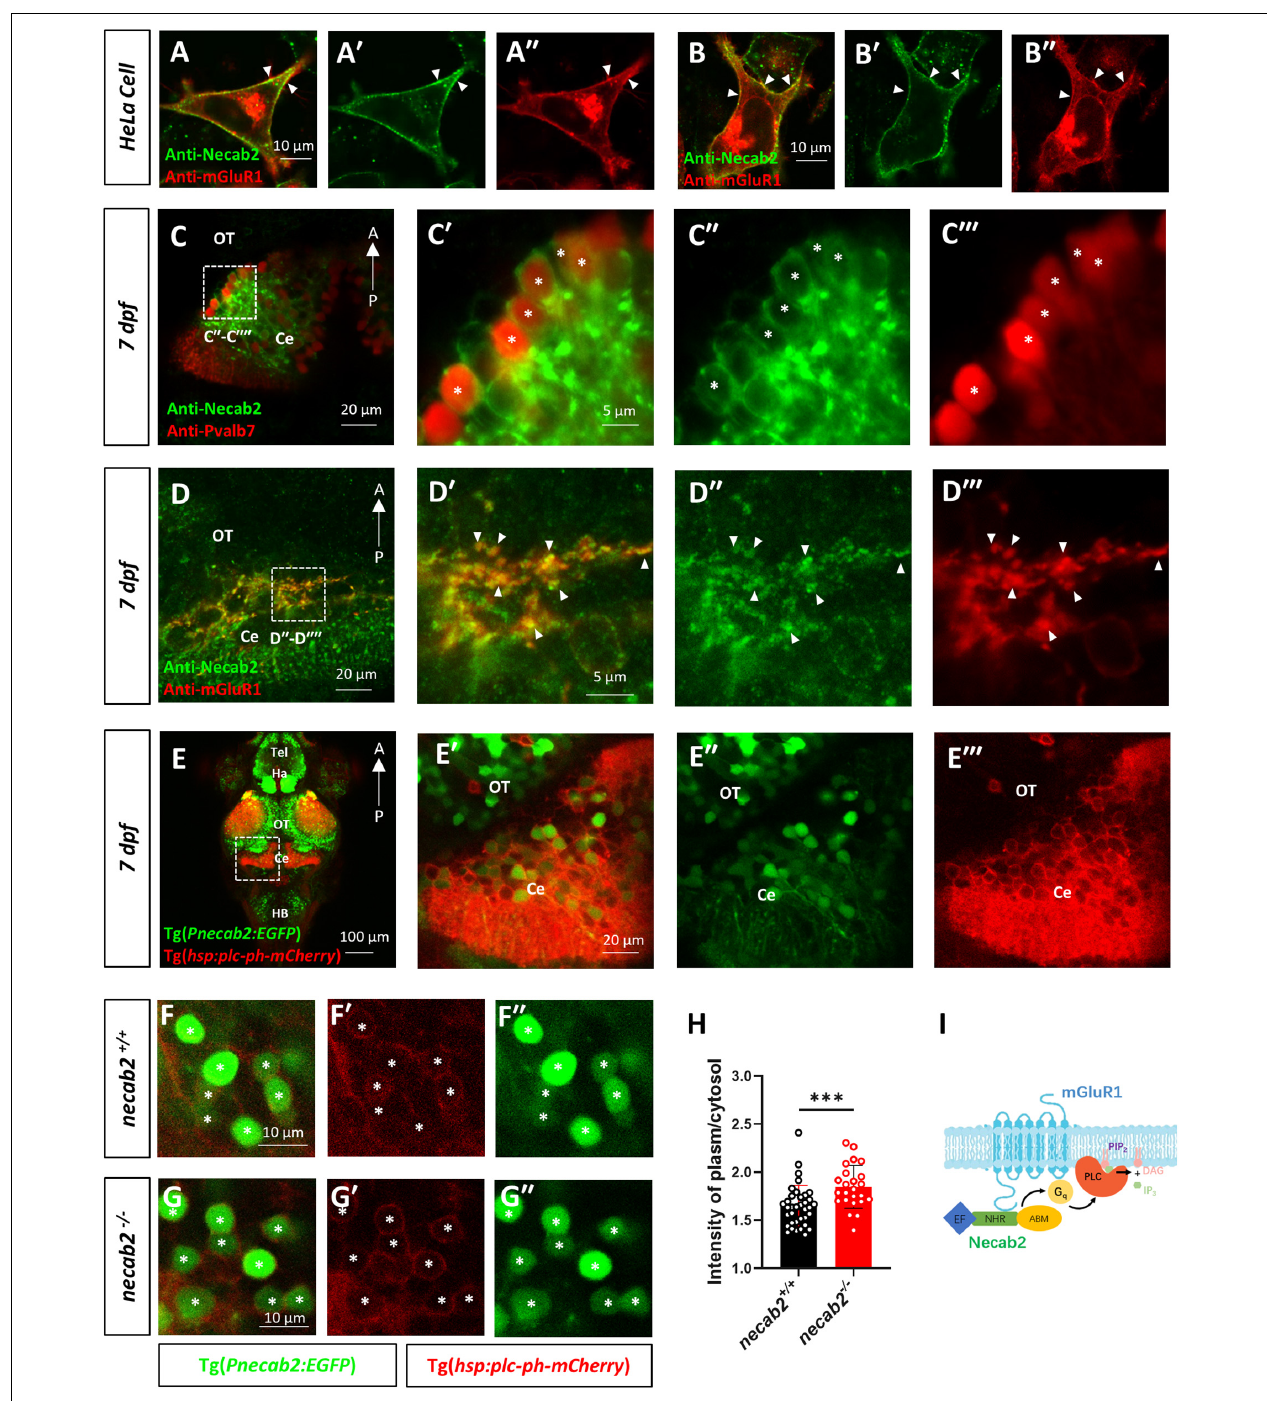
FIGURE 7 | Necab2 co-localizes with mGluR1 and promotes PIP2-PLC-PKC signaling. (A–A (cid:48)(cid:48) ,B–B (cid:48)(cid:48) ) NECAB2 and mGluR1 colocalize at the cell membrane of HeLa cells (arrowheads). The HeLa cells were transiently transfected with EGFP-NECAB2 and mGluR1-mCherry and live imaging was conducted with the confocal microscope. Scale bar = 10 µ m. (C–C (cid:48)(cid:48)(cid:48) ) Co-immunofluorescent staining of anti-Necab2 with anti-Pvalb7 in 7 dpf larvae showed that Necab2 was expressed in the Purkinje cells in the cerebellum (asterisks). Scale bar = 20 µ m (C) . The region in the dashed white box (C) is shown at higher magnification on the right (C (cid:48) –C (cid:48)(cid:48)(cid:48) ) . Scale bar = 5 µ m. (D–D (cid:48)(cid:48)(cid:48) ) NECAB2 and mGluR1 co-localized in the cerebellum of the zebrafish larvae (arrowheads). The necab2 + / + larvae at 7 dpf were processed for anti-Necab2 and anti-mGluR1 immunofluorescence staining following fixation. Scale bar = 20 µ m (D) . The region in the dashed white box (D) was shown at higher magnification on the right (D (cid:48) –D (cid:48)(cid:48)(cid:48) ) . Scale bar = 5 µ m. (E–E (cid:48)(cid:48)(cid:48) ) Live imaging of necab2 + / + larvae at 7 dpf in Tg( hsp70:plc-ph-mCherry ) and Tg( Pnecab2:EGFP ) background by confocal microscope. Z-stack, Maximum intensity projection. Scale bar = 100 µ m (E (cid:48) ) . The cerebral region (in the dashed white box) was shown at higher magnification on the right (E (cid:48) –E (cid:48)(cid:48)(cid:48)(cid:48) ) . Scale bar = 20 µ m. (F–F (cid:48)(cid:48) ,G–G (cid:48)(cid:48) ) The necab2 − / − larvae accumulated more PLC-PH-mCherry at the